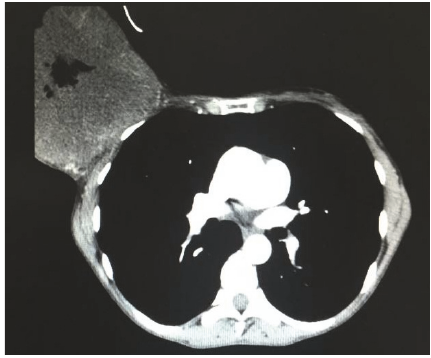
Figure 2: Chest tomography at the admission.